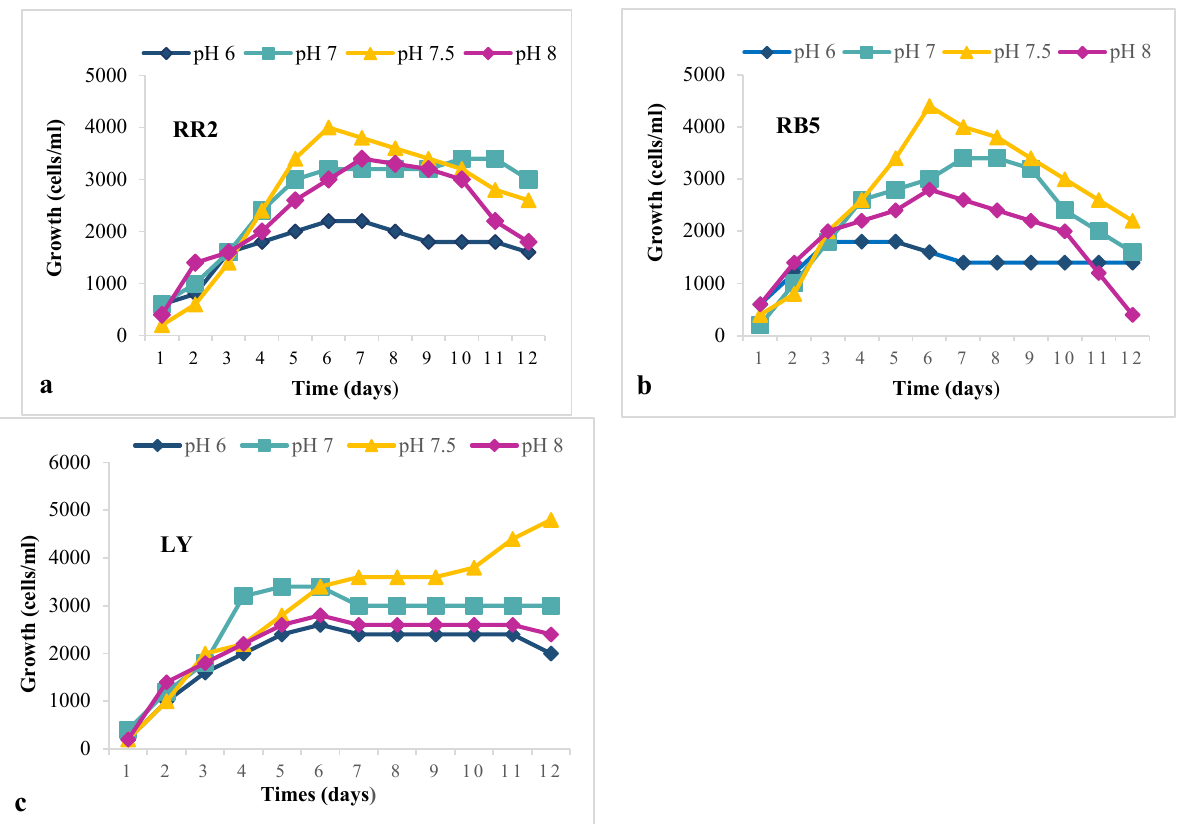
Figure 6. Growth curve of P. caudatum UR03 in culture medium containing azo dyes, RR2 ( a ), RB5 ( b ) and LY ( c ) at different pH values.